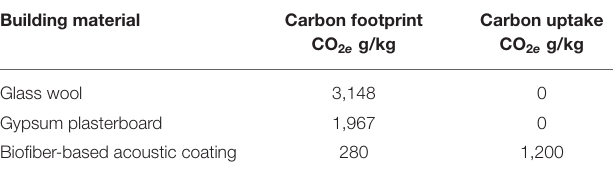
TABLE 1 | Carbon footprint of the building materials used in this